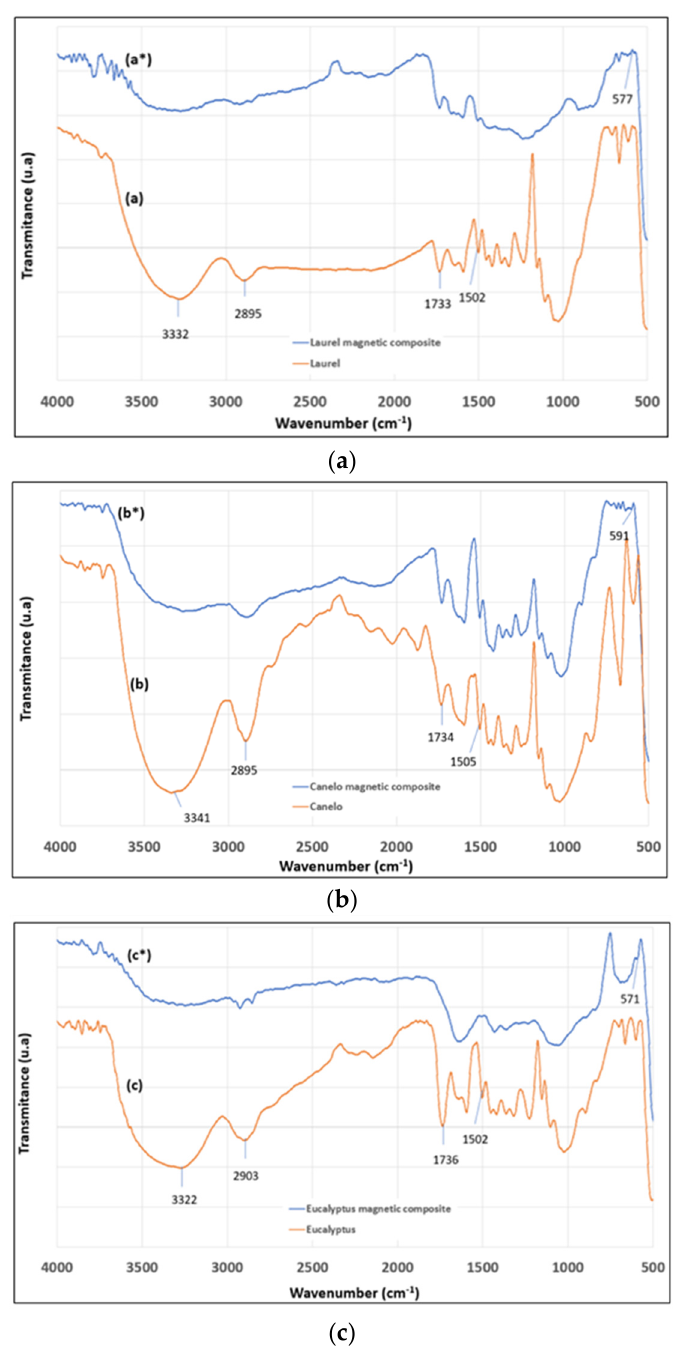
Figure 1. FTIR spectra of lignocellulosic biomass before (x) and after impregnation with magnetite (x*): ( a ) (a* vs. a) laurel, ( b ) (b* vs. b) canelo and ( c ) (c* vs. c) eucalyptus.